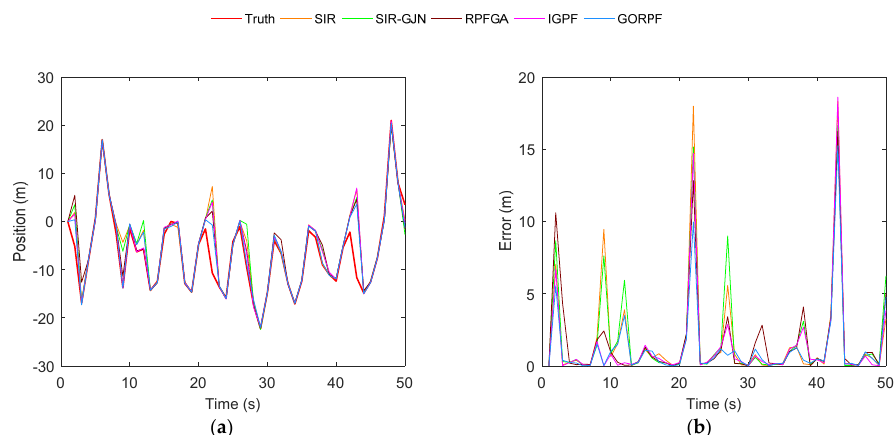
Figure 6. Target tracking performance of the five particle filter-based algorithms (with 100 particles) under small measurement noise condition ( σ 2 v = 0.04). ( a ) Tracking trajectories; ( b ) Absolute errors at each time step.